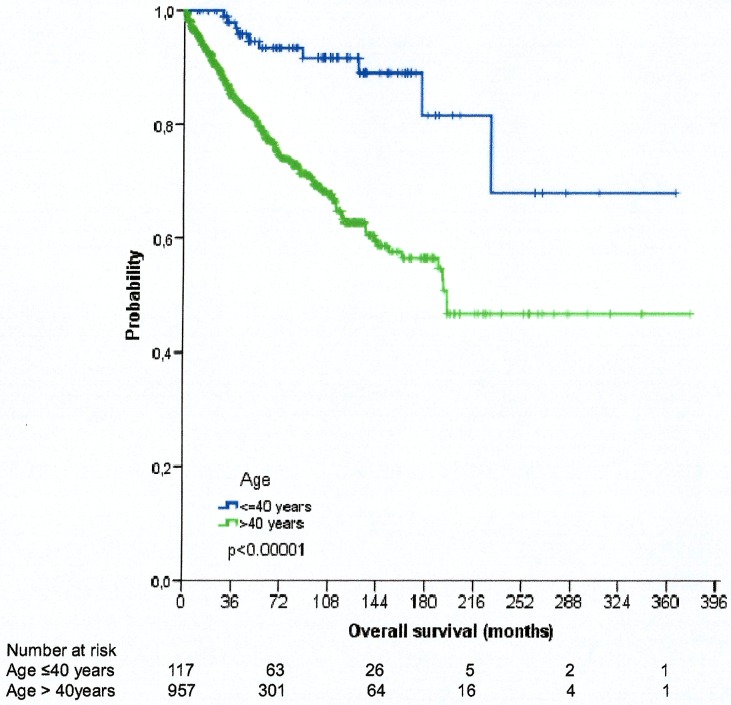
Kaplan-Meier estimates of survival (in years) according to age (over or under 40 years of age).